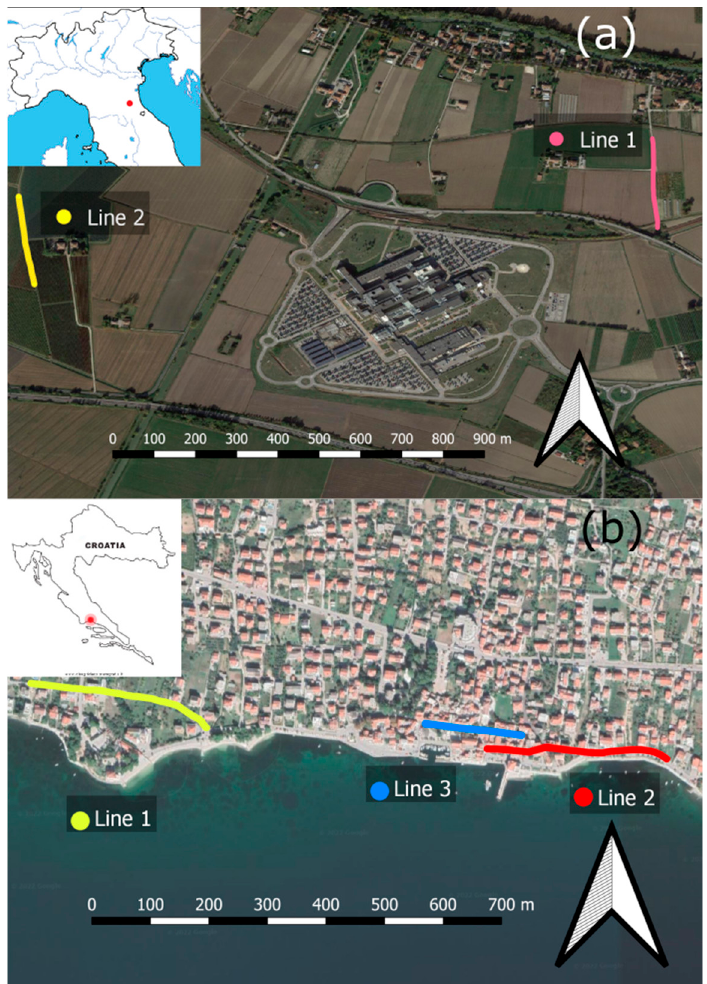
Figure 1. ( a ) Location of the lines acquired in the area of Ferrara, Italy. ( b ) Location of the lines acquired in Kaštela, Croatia. Images created on Google Earth Pro on 30 March 2022.